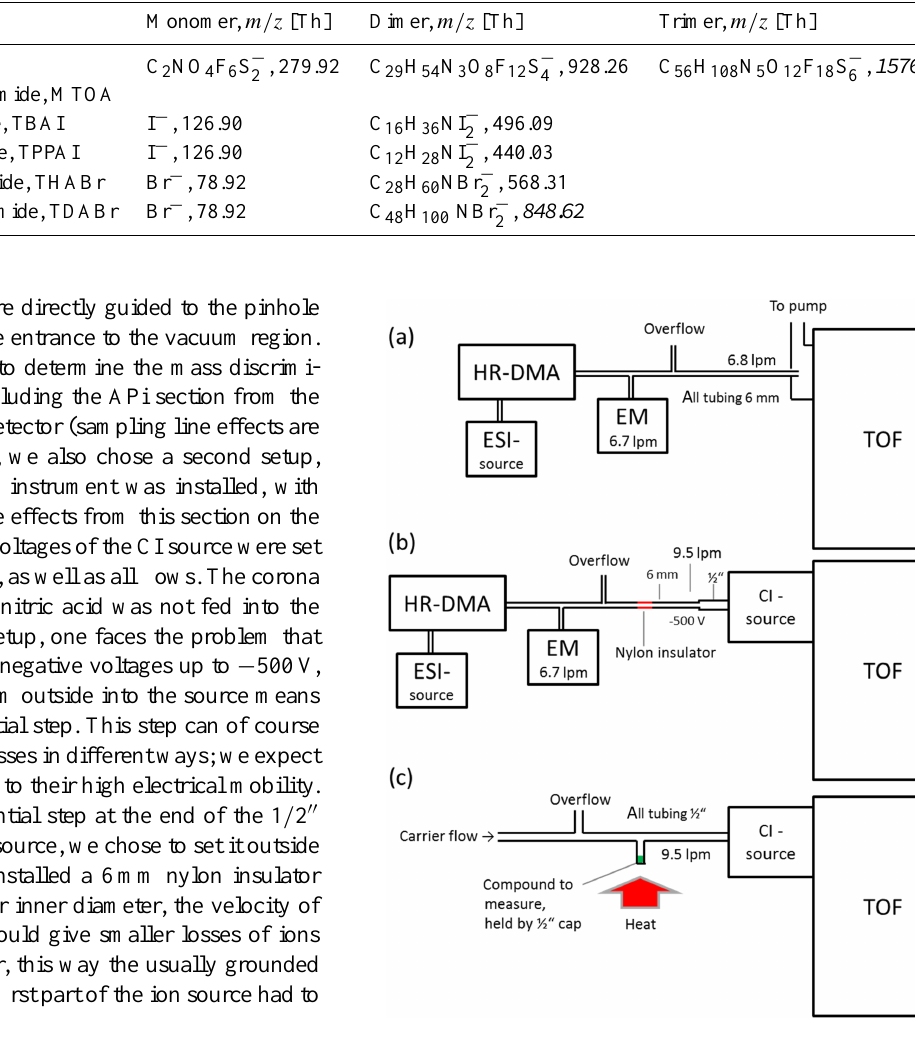
Figure 1. Schematic setup for the three types of experiments con- ducted. (a) HR-DMA measurement without CI source, APi-TOF only. (b) HR-DMA setup with CI ion source. The 1 / 2 (cid:48)(cid:48) sampling line of the CI source was at a potential of − 500V. To minimize losses the potential step from ground to − 500V was installed at the 6mm line with a nylon insulator. (c) Setup for the depletion method. A small sample was stored in a 1 / 2 (cid:48)(cid:48) cap and slowly heated with a standard heat gun. Potential overly high or overly small diffusion of the sample into the carrier flow can be controlled by varying length and inner diameter of the vertical connection between the sample and the carrier flow